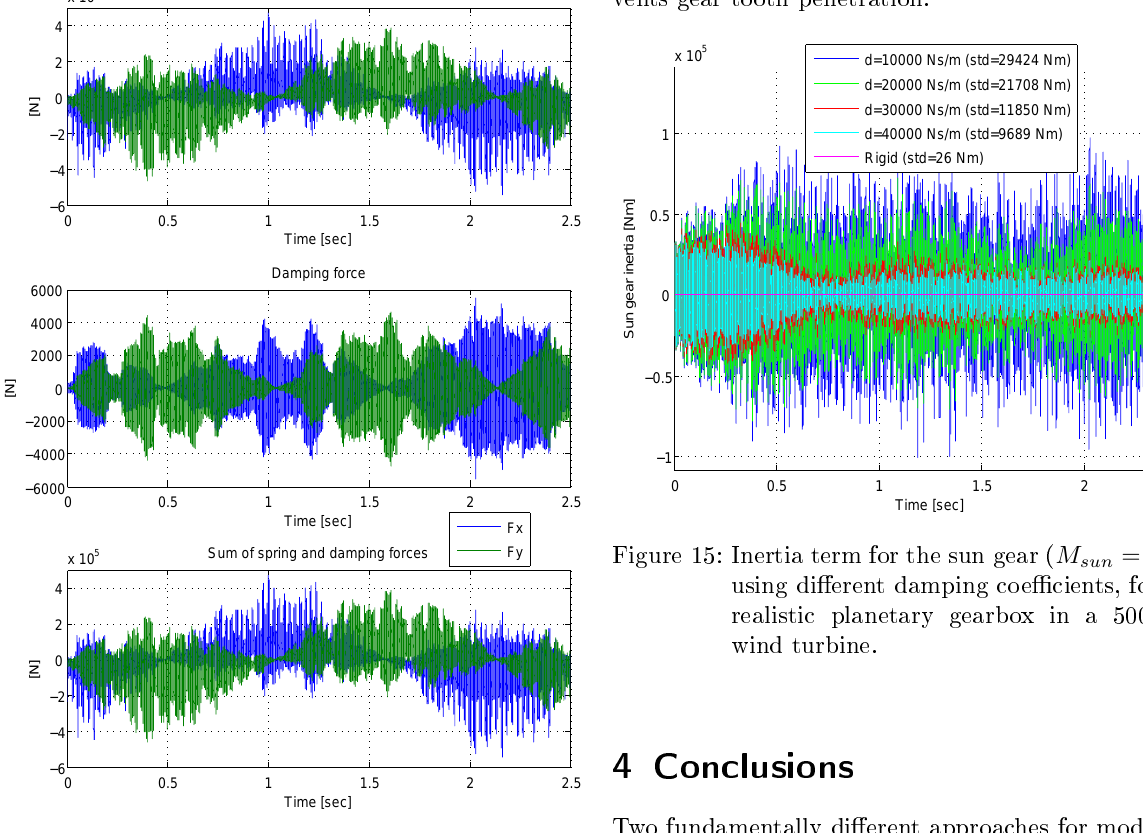
Figure 13: The damping force is direction-dependent as the spring forces are (blue color for x , green color for y ). Damping forces increase as the spring forces increase and vice versa ( d = 20 · 10 3 Ns/m was used). It can be seen that spring forces are dominant (cid:21) single planet forces are shown.